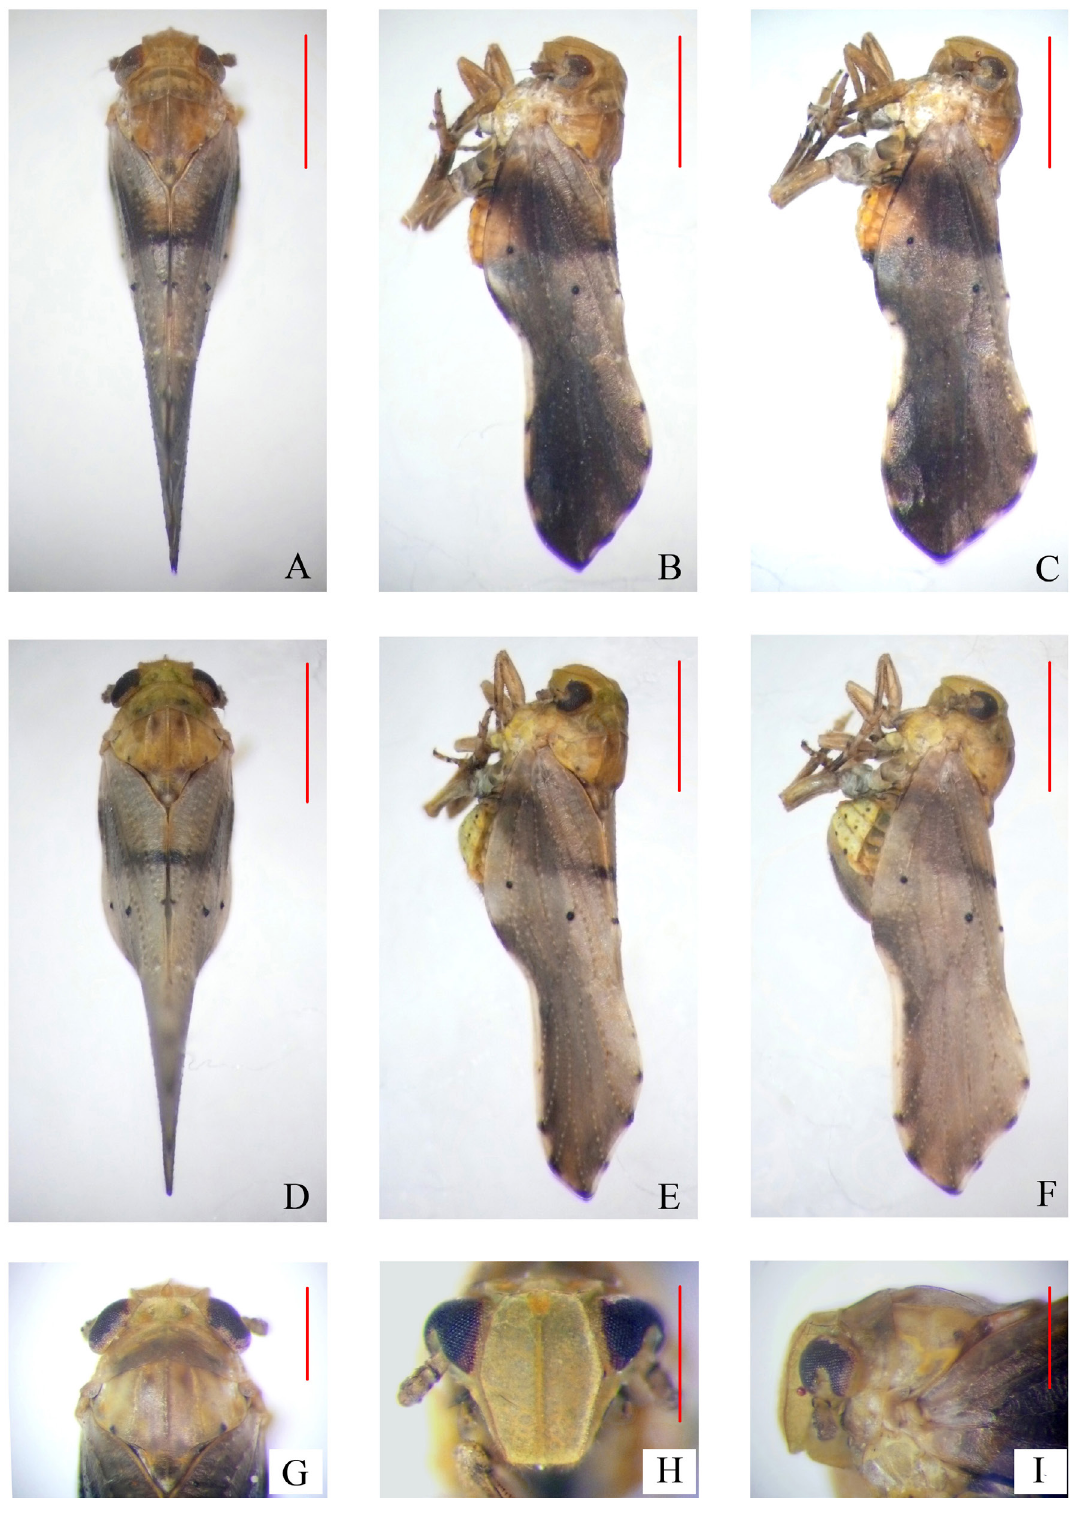
Fig. 5. Arcofaciella verrucosa Fennah, 1956. A–C, G–I = ♂ (GUGC-FDTA-20190619); D–F = ♀ (GUGC-FDTA-20190620). A . Male habitus, dorsal view. B–C . Same, lateral view. D . Female habitus, dorsal view. E–F . Same, lateral view. G . Head and thorax, dorsal view. H . Face. I . Frons, lateral view. Scale bars: A–F = 1 mm; G–I = 0.5